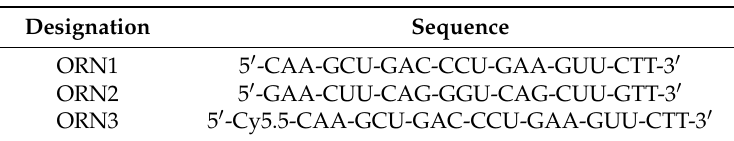
Table 2. Sequences of